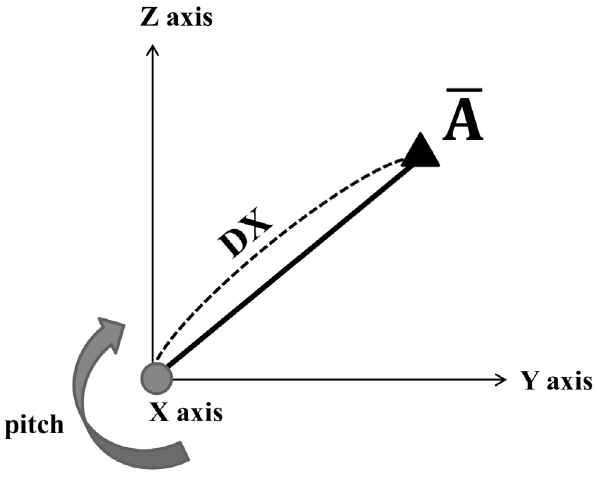
Figure 6. DB: Locating error (distance) of a landmark (A). A represents an averaged landmark of A.